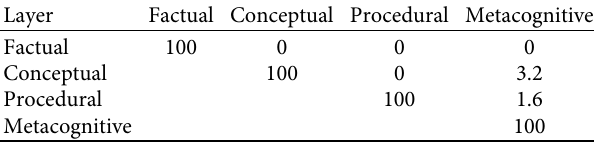
Table 8: The percentage overlapping of edges in the MKN network.